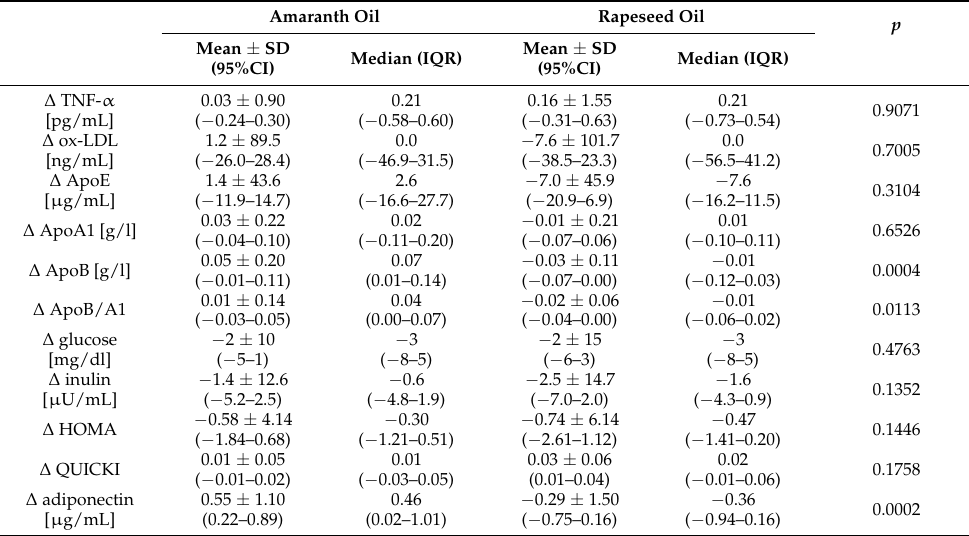
Table 2. Differences in changes in analyzed parameters between